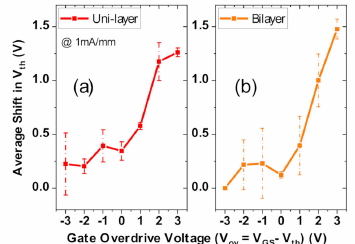
Figure 14. Average V th shift comparison between Wafer M (uni-layer) and Wafer B (bilayer) from double pulsed measurements. ( a , b ) are V th shifts for quiescent V GS stress voltages up to gate overdrive = 3V (quiescent V = 0 V), for Wafer M with V = 0 to 7 V ( a ) and for Wafer B ≈ 4V and V DS th GS,Stress with V th ≈ 3 V and V GS,Stress = 0 to 6